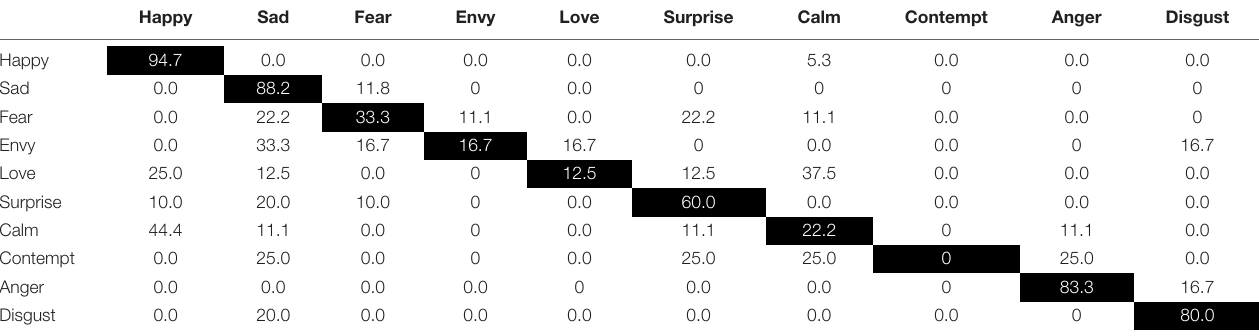
TABLE 7 | Classification Matrix using all 11 AUs common to ICP prototypes for Studied Emotions. Happy Sad Fear Envy Love Surprise Calm Contempt Anger Disgust Happy